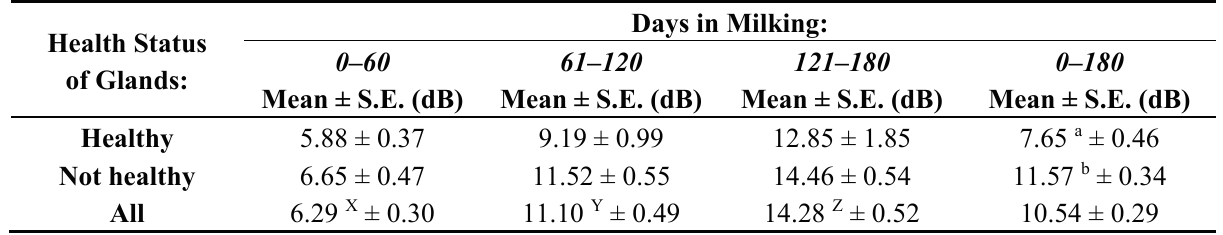
Table 11. Overall means and standard errors of the amplitude of peak FFT_P 3 , according to health statuses and lactation stages.